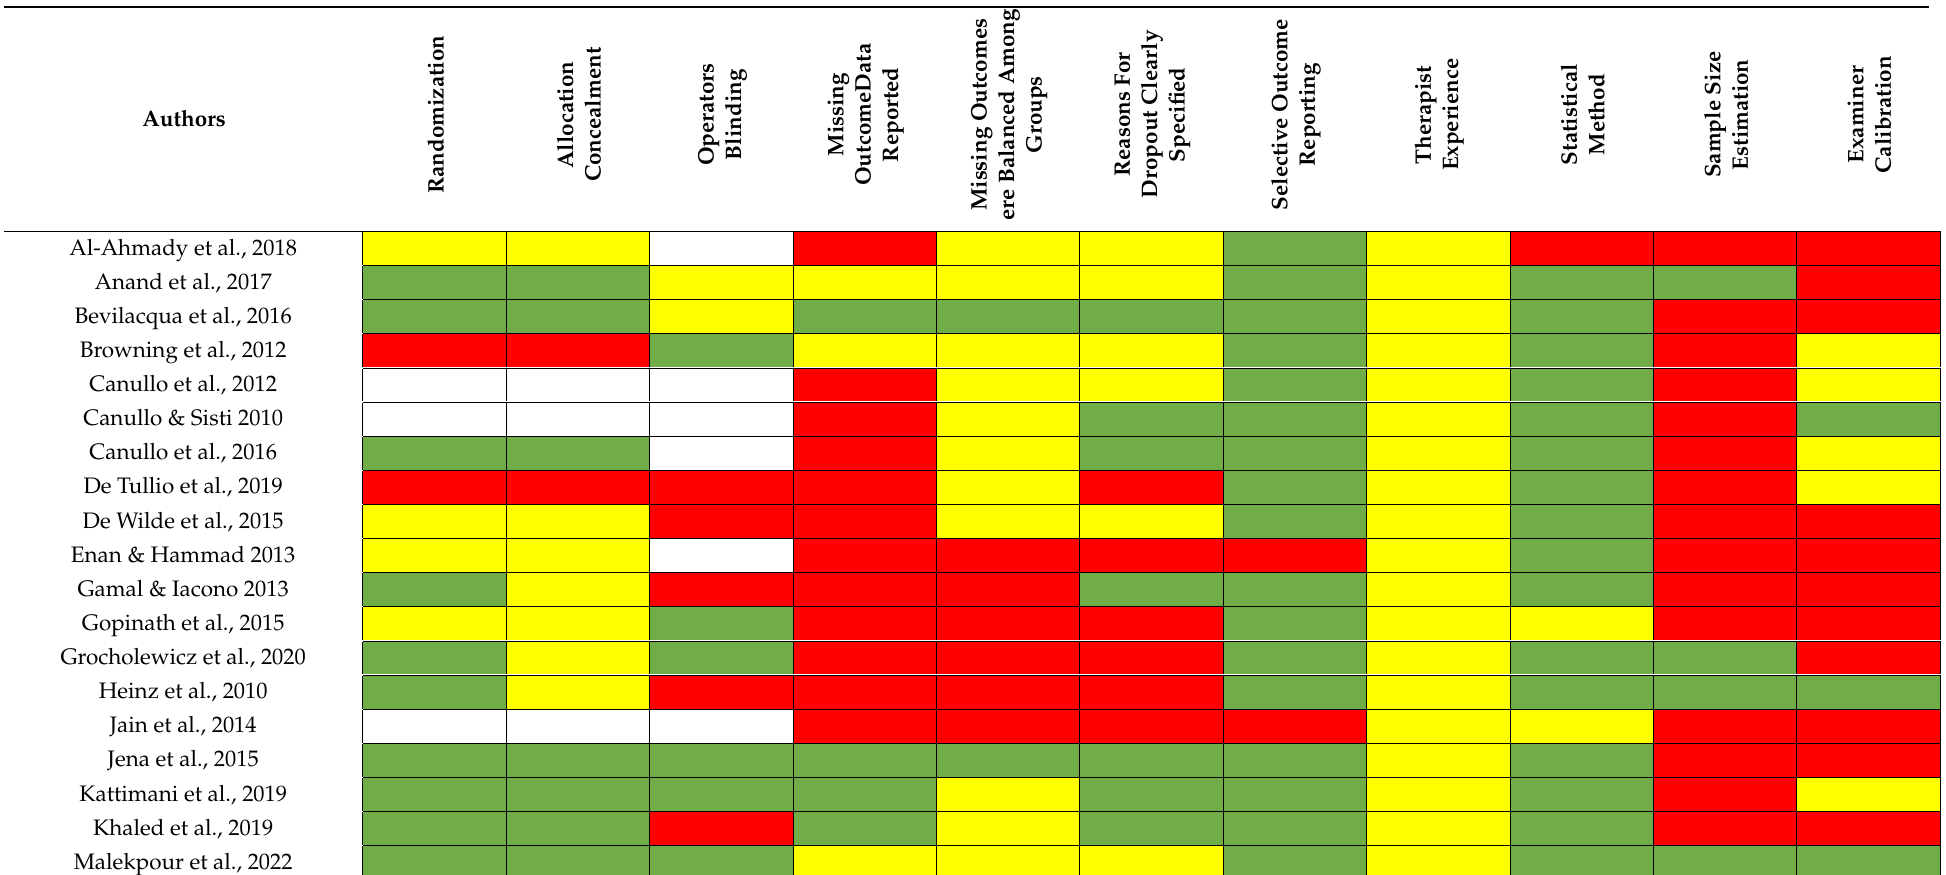
Table 6. Quality analysis of the included